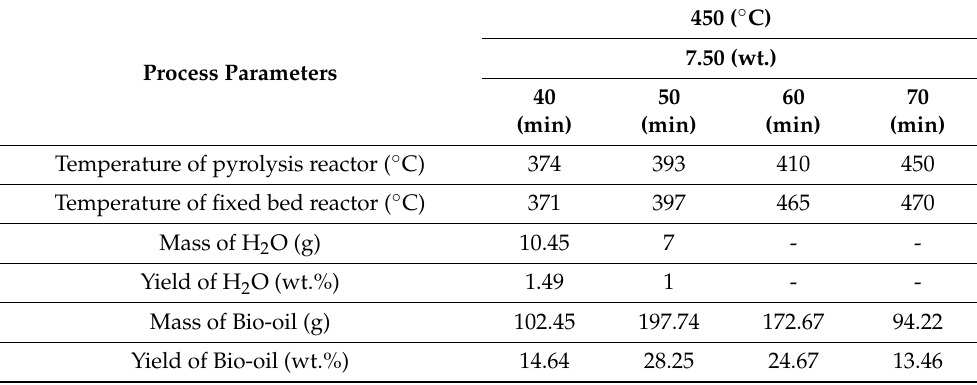
Table 6. Process parameters, mass balances, and partial yields of bio-oil and H 2 O obtained during course of reaction (50–80 min) of experiment using 7.5%